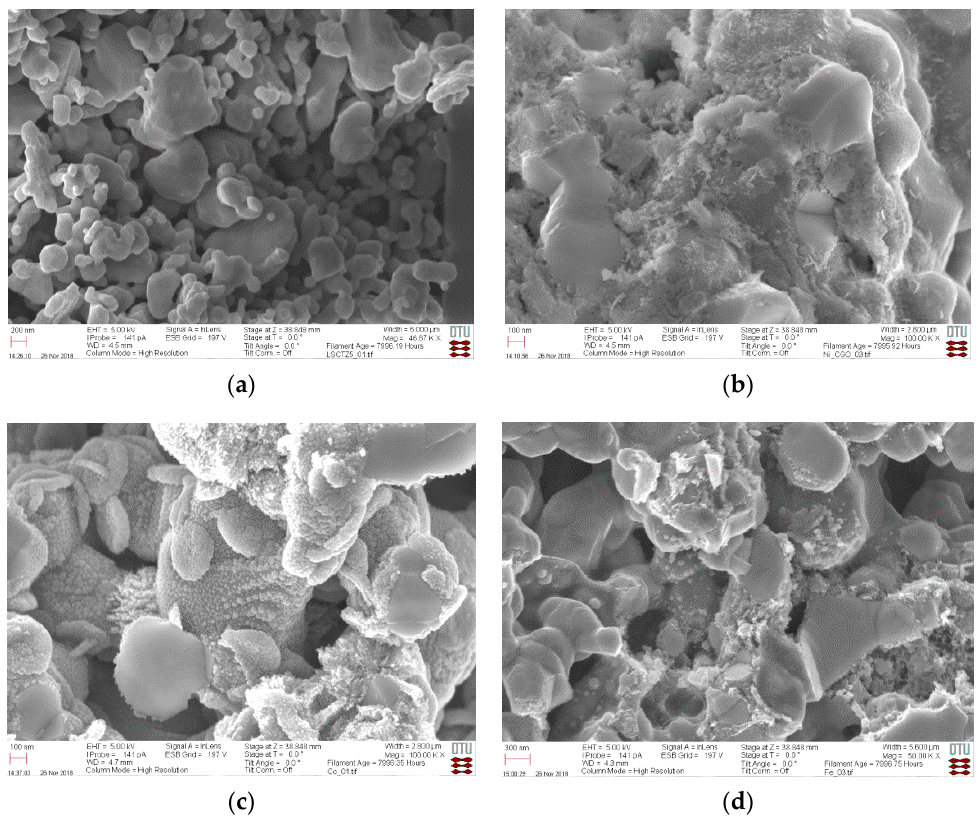
Scanning electron microscopy (SEM) images of ( a ) non-infiltrated LSCTZ5, ( b ) Ni-gadolinium-doped cerium oxide (CGO)-infiltrated LSCTZ5, ( c ) Co-infiltrated LSCTZ5, and ( d ) Fe-infiltrated LSCTZ5.